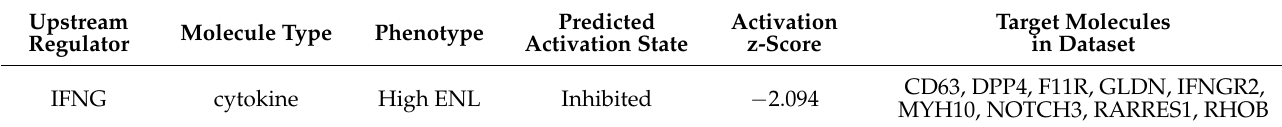
Table 4. Putative upstream regulators showing activation or inhibition in high- ENL and/or low-ENL excreters. The upstream regulators are ordered by difference in the high-ENL activation z-score and low-ENL activation